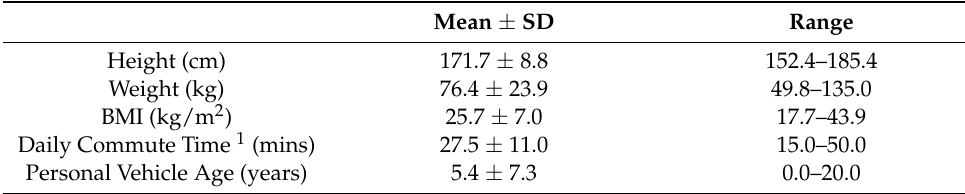
Table 3. Field vibration study participants’ demographic summary ( n = 12).